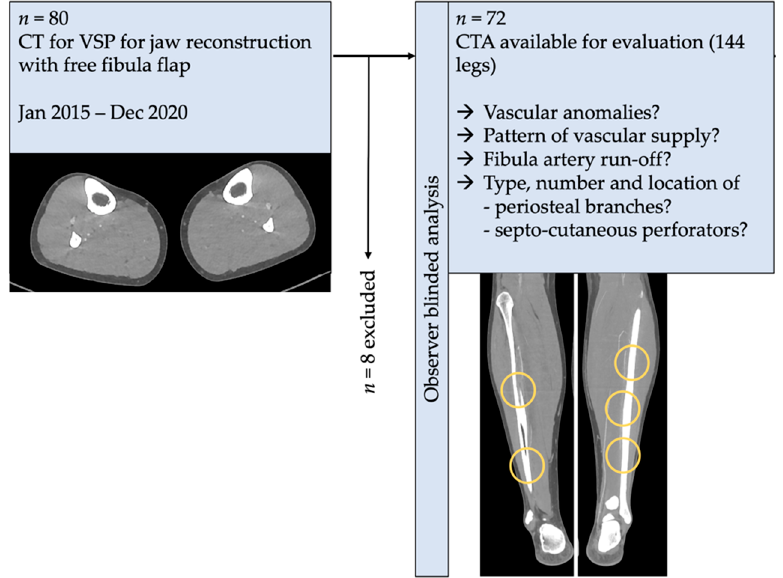
Figure 1. Schematic workflow of the present study. Only computed tomography angiography (CTA) DICOM-datasets of virtual planned jaw reconstructions were included in the investigation. The architecture of lower leg vascular perfusion was analyzed. Number, type of perforator (periosteal branch, septo-cutaneous), and distance to the distal tip of the fibula and between the branches were assessed.